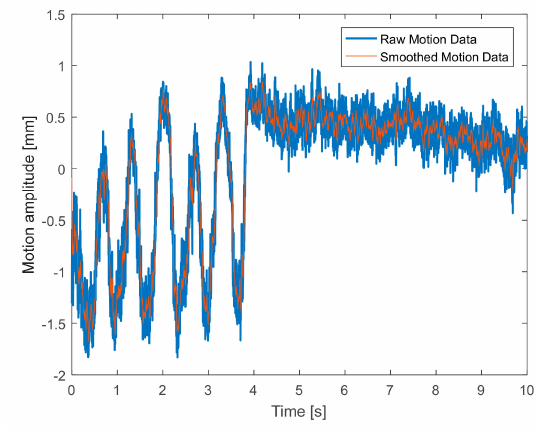
Figure 11. Detected movement ( x(t) ) under normal / interrupted